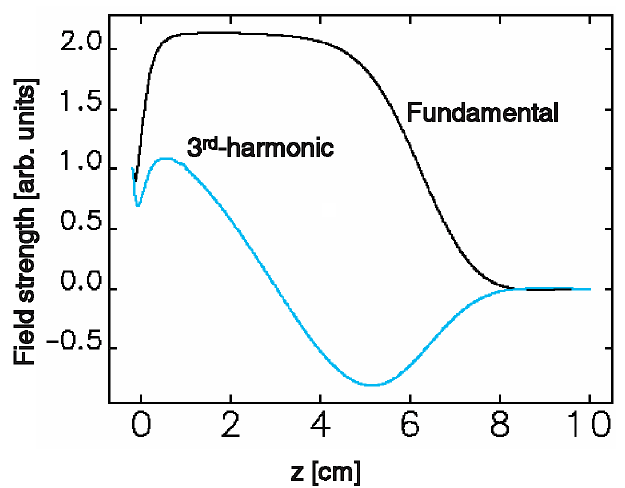
FIG. 9. (Color) Fundamental and 3rd-harmonic on-axis fields for the model gun cavity. The fields have been normalized to unity at the cathode